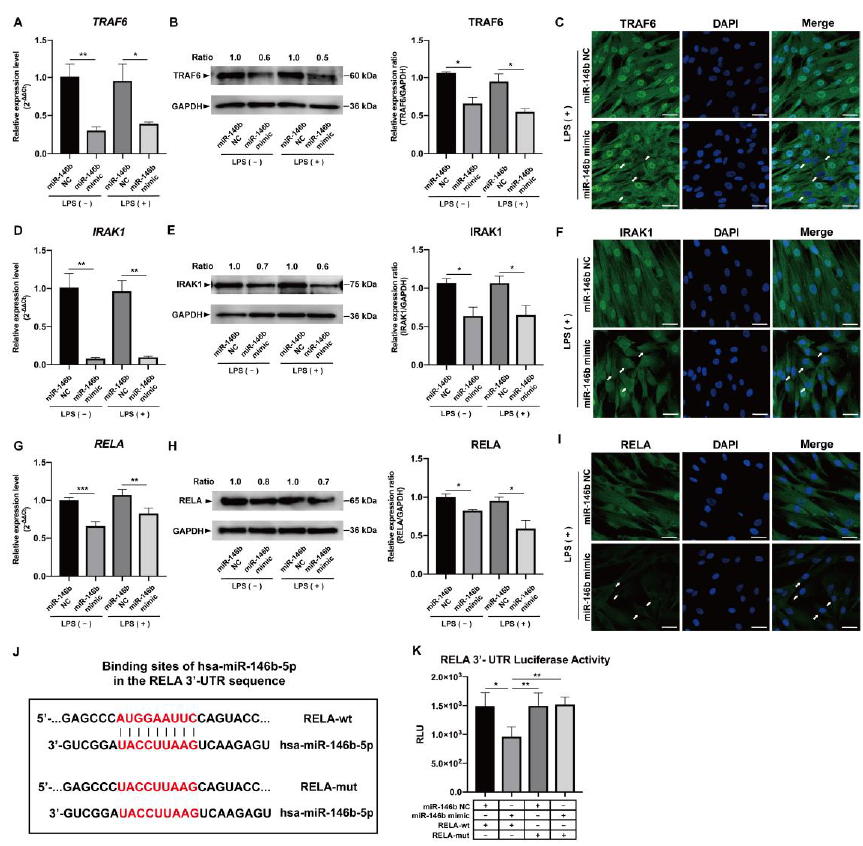
Figure 4. hsa-miR-146b-5p mimic down-regulates TRAF6, IRAK1, and RELA in LPS-stimulated hDPCs. hsa-miR-146b-5p mimic significantly down-regulated the mRNA ( A , D , G ) and protein ( B , C , E , F , H , I ) expression of TRAF6, IRAK1, and RELA in hDPCs under 2 h LPS stimulation (mean ± SD, n ≥ 3 ). ( J ) Wild-type (RELA-wt) and mutated (RELA-mut) target sequences of hsa-miR-146b-5p